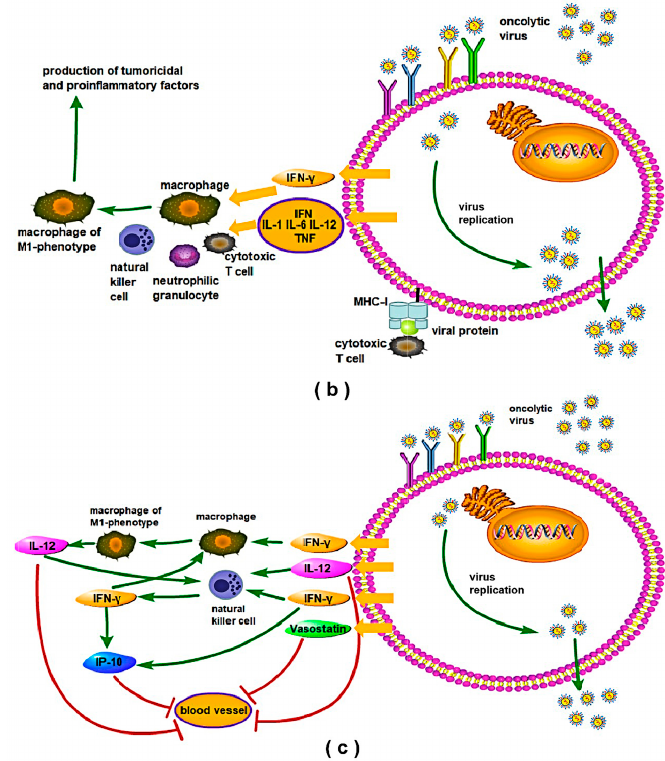
Figure 3. Possible mechanisms of the lysis of tumor cells upon infection with an oncolytic virus. ( a ) Binding to receptors initiates the internalization of the virus, which then release the viral nucleic acid, starting viral proliferation and release, leading to the apoptosis of tumor cells. ( b ) A pathogen-associated molecular pattern stimulates the production of antiviral cytokines (IFN- γ , IL-1, IL-6, IL-12, tumor necrosis factor [TNF]), which leads to the activation of immune cells, mediating cytotoxicity and phagocytosis. Meanwhile, major histocompatibility complex (MHC)-I-mediated presentation of viral proteins activates CD8 + cytotoxic T-cells, triggering lysis of the oncolytic virally-infected tumor cells. ( c ) Secretion of IFN- γ and IL-12 might initiate the complex interplay between IFN- γ , IL-12, natural killer (NK)-cells, and IFN- γ -inducible protein (IP-10), leading to the eventual limitation of tumor angiogenesis. Moreover, externalization of vasostatin is also involved in the inhibition of tumor angiogenesis. The arrows indicate the various steps and the components of an oncolytic virus during exerting the lysis of tumor cells, with the bar indicating their participation inhabiting the tumor